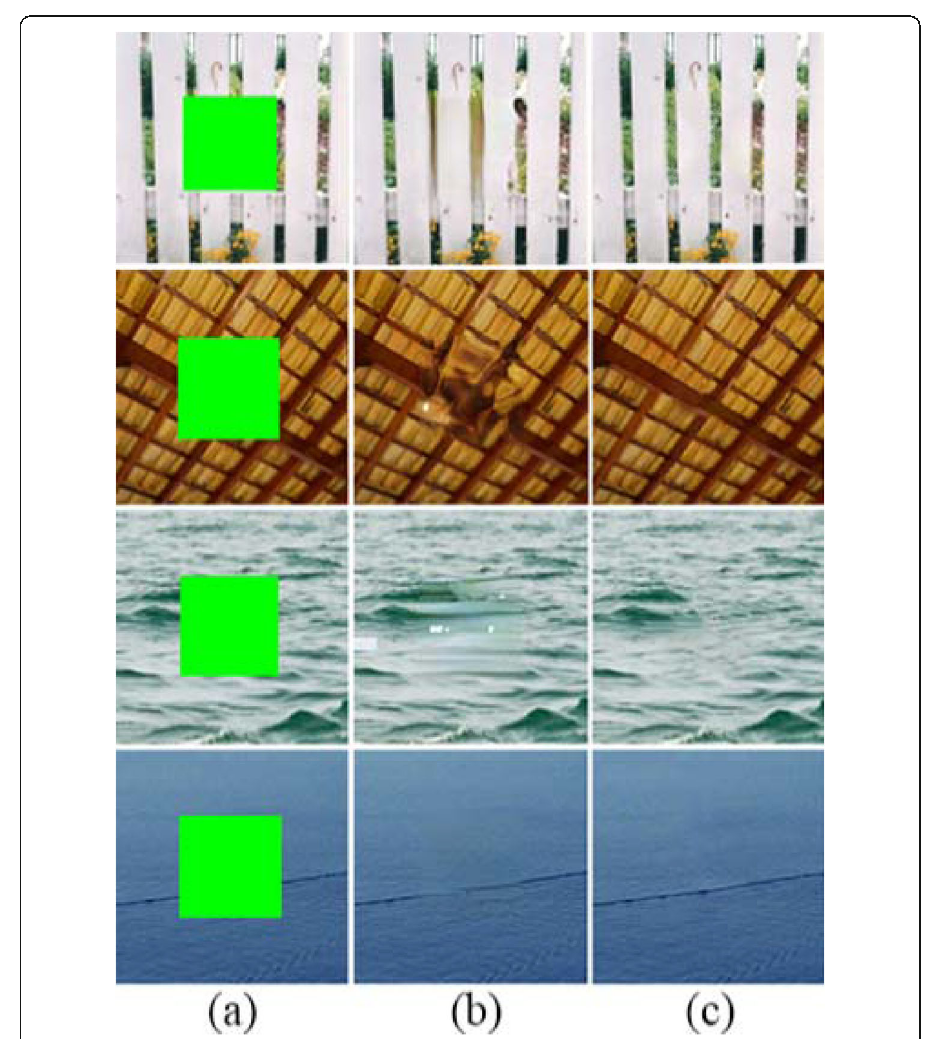
Fig. 8 Comparison of results. a Input. b Results in Ref. [23]. c Our